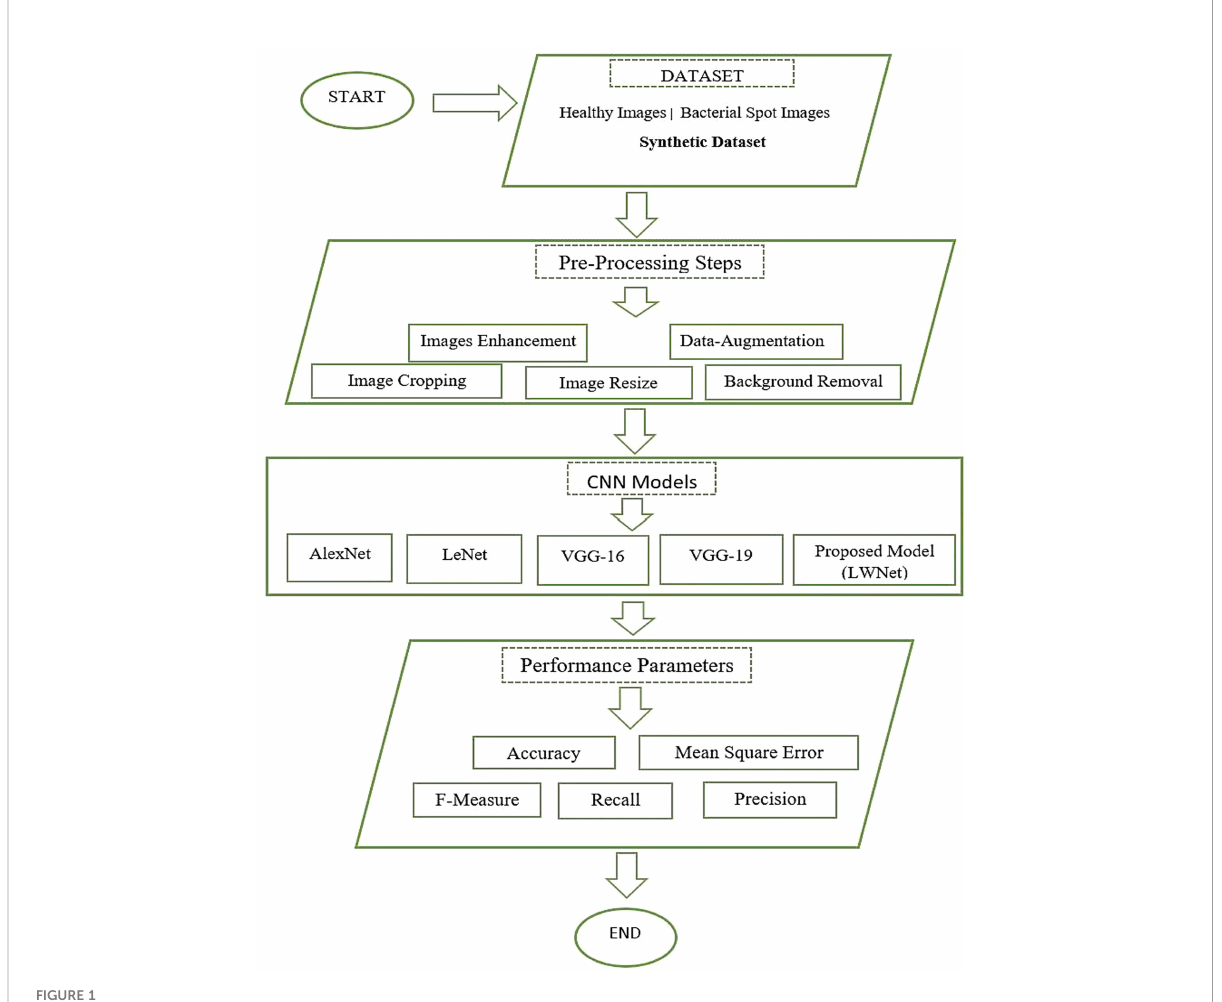
FIGURE 1 Data fl ow chart of the proposed LWNet model